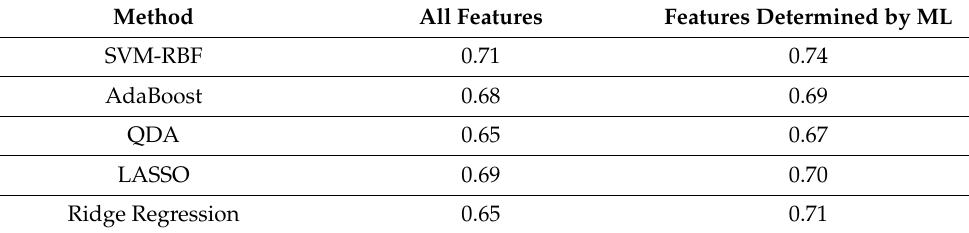
Figure 4. Histogram for days between admission and readmission. The histogram bin size was 30 days. Table 2. Model performance. Area under the receiver operating characteristic (ROC) curve for predicting 30-day readmission using different methods on the testing dataset. The dataset size for training all machine learning models was 4096 cases. The testing dataset size for validating the performance of all machine learning models was 6798